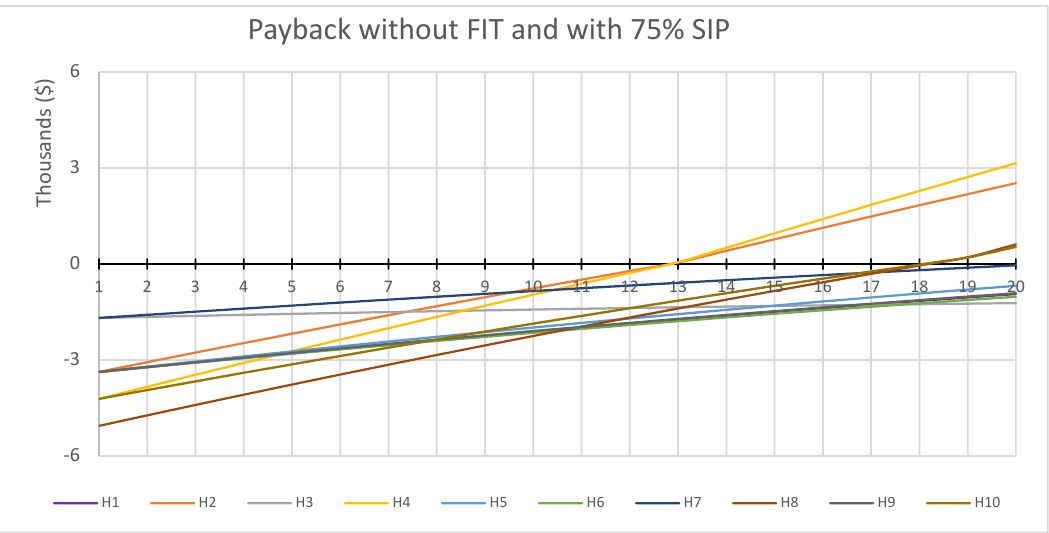
Figure 11. Economic model results demonstrate the payback time for the rooftop PV systems with- out FIT but with 75% SIP for houses H1:H10.